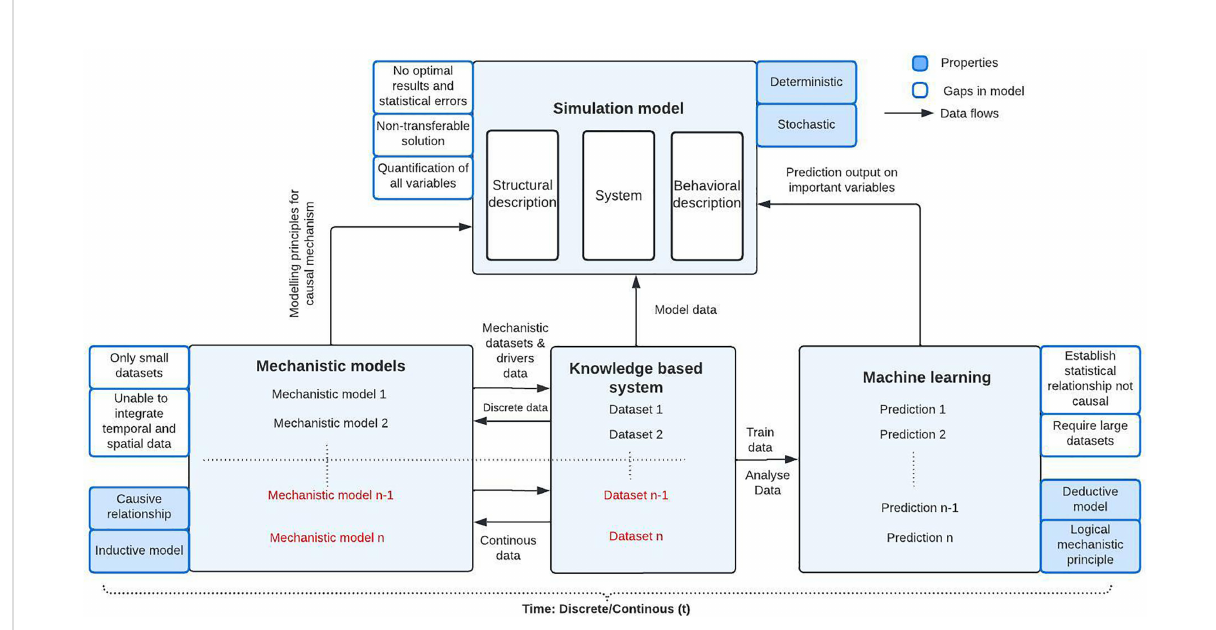
FIGURE 2 Framework of complex system model of obesity (national-global level of